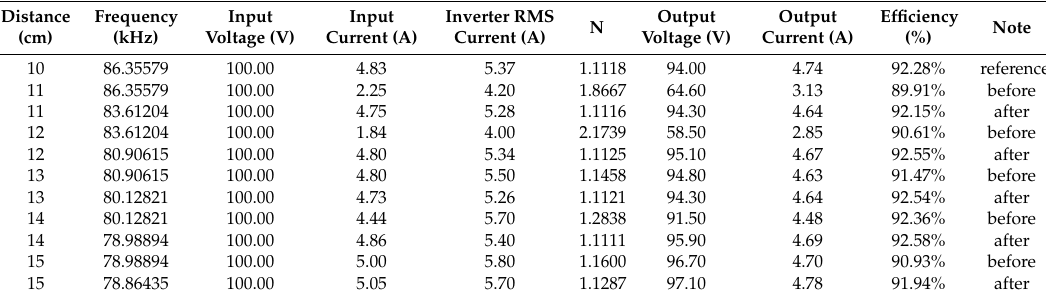
Table 3. Frequency adjustment test results from 10 cm to 15 cm.